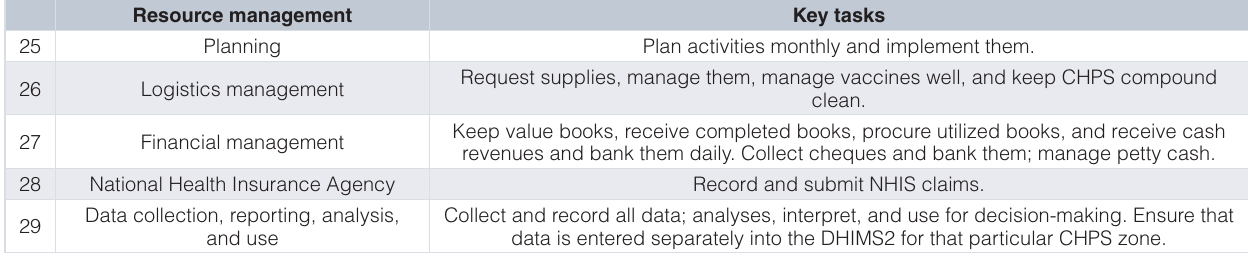
Disease prevention and environmental